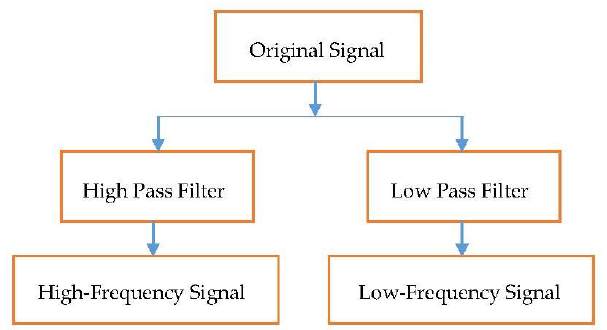
Figure 3. Wavelet decomposition scheme.